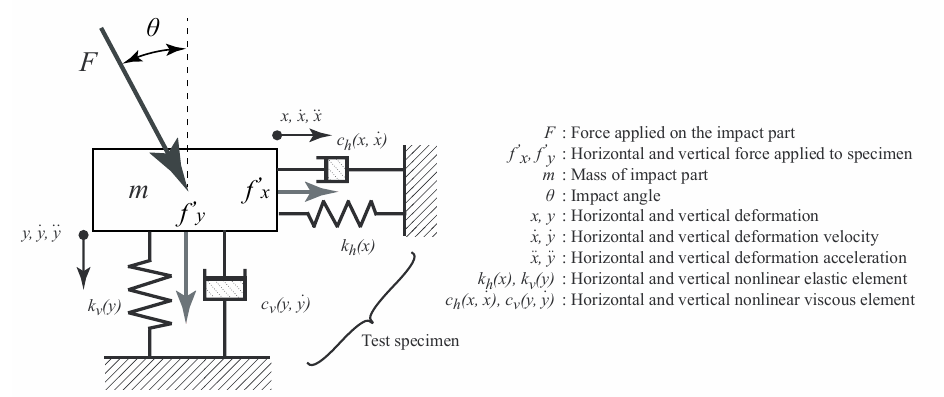
Figure 2. 2-D mathematical model of sport surface proposed in this study. The model consisted of horizontal and vertical elements. By using experimental data acquired from 2-D impact tests with various impact angles and intensities, the parameter set of each element was identified